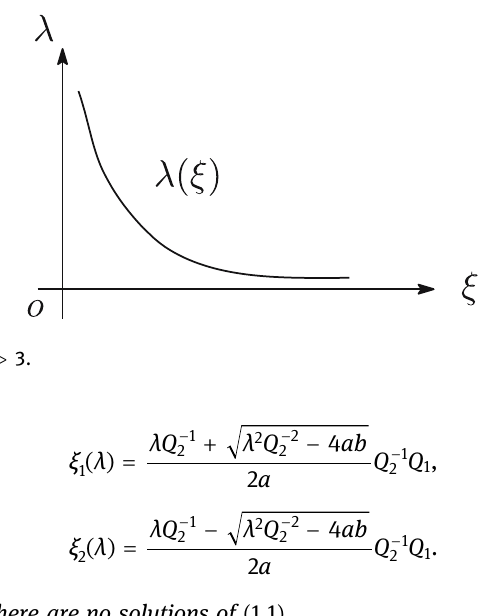
Figure 2: The graph of λ ξ ( ) for p 3 > .